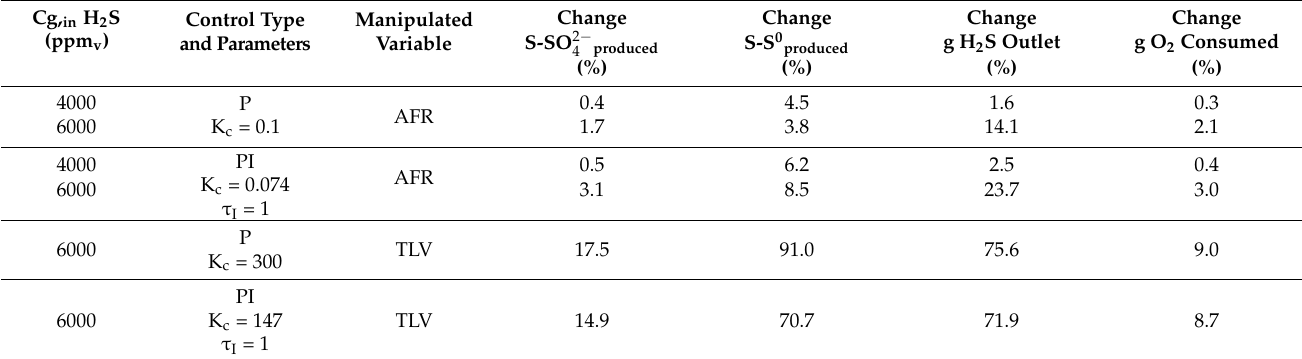
Table 8. Improvement on the main process performance variables for AFR-CL and TLV-CL facing H 2 S inlet concentration changes using P and PI